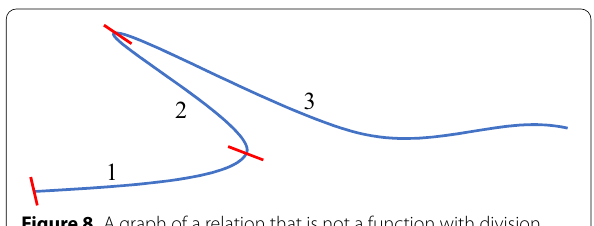
Textures on the edges